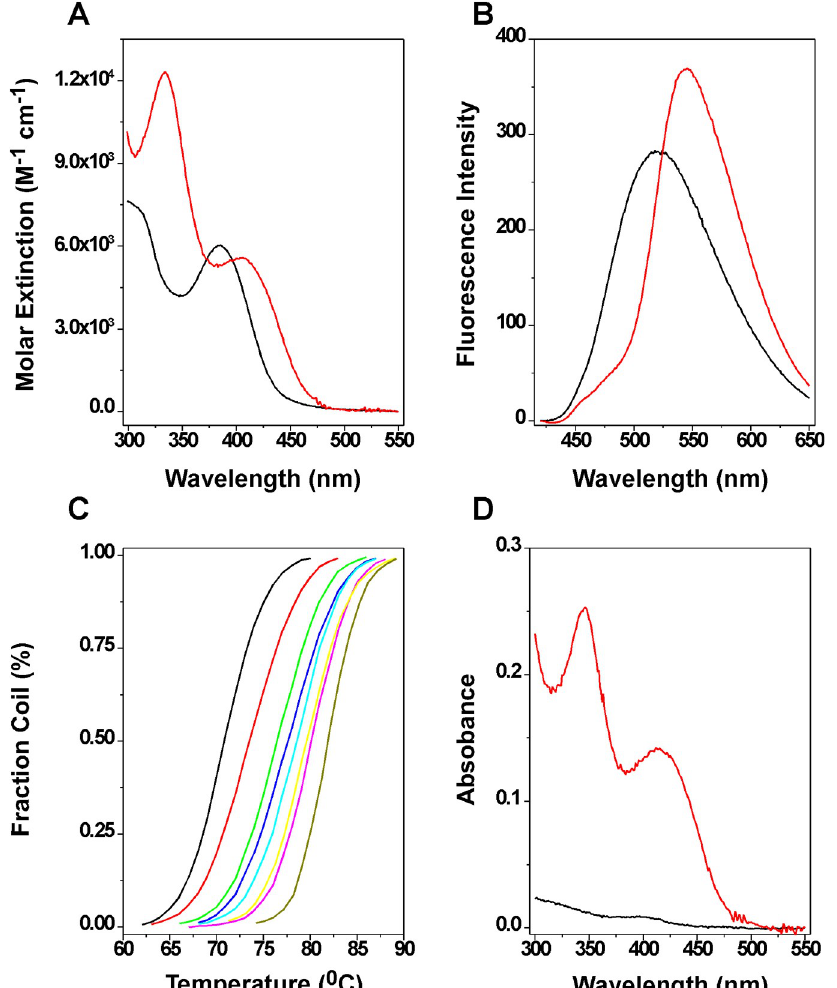
Fig 5. Binding of FP-11g to salmon testes DNA in 1 × BPE buffer (6 mM Na 2 HPO 4 , 2 mM NaH 2 PO 4 , and 1 mM EDTA, pH 7). (A) Visible absorption spectra of free (black line) and DNA bound (red line). (B) Fluorescence emission spectra of free (black line) and DNA bound (red line). The fluorescence emission spectra were recorded with λ em = nm. (C) DNA UV melting of salmon testes DNA in the presence of various concentrations of FP-11g. The FP- 11g concentrations are 0, 2, 5, 7.5, 10, 15, 20, and 40 μ M from left to right. (D) The DNA dialysis assay was performed as described in the Methods. Visible absorption spectra of FP-11g inside the dialysis bag (red line) and outside dialysis bag (black line).